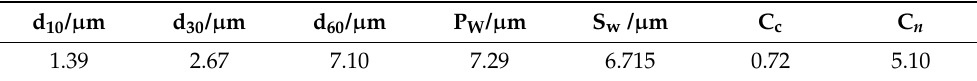
Figure 4. Accumulative tailing content and proportion curve of each particle size. Table 2. Physical properties of tailings.